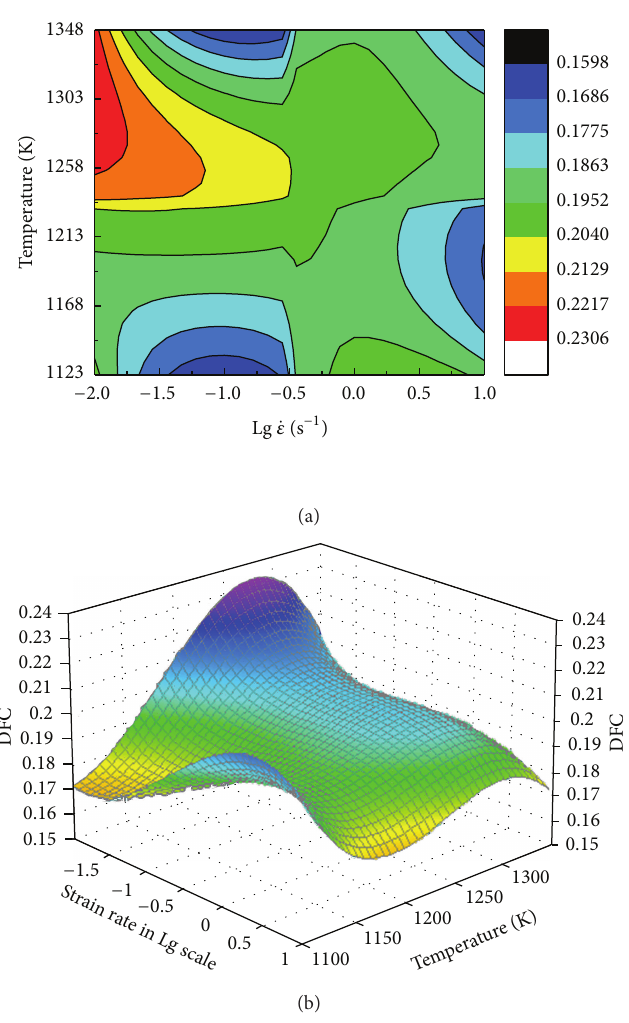
Figure 9: The temperature and strain rate effect on the ductile fracture criteria of 42CrMo steel: (a) contour plot, (b) response surface.